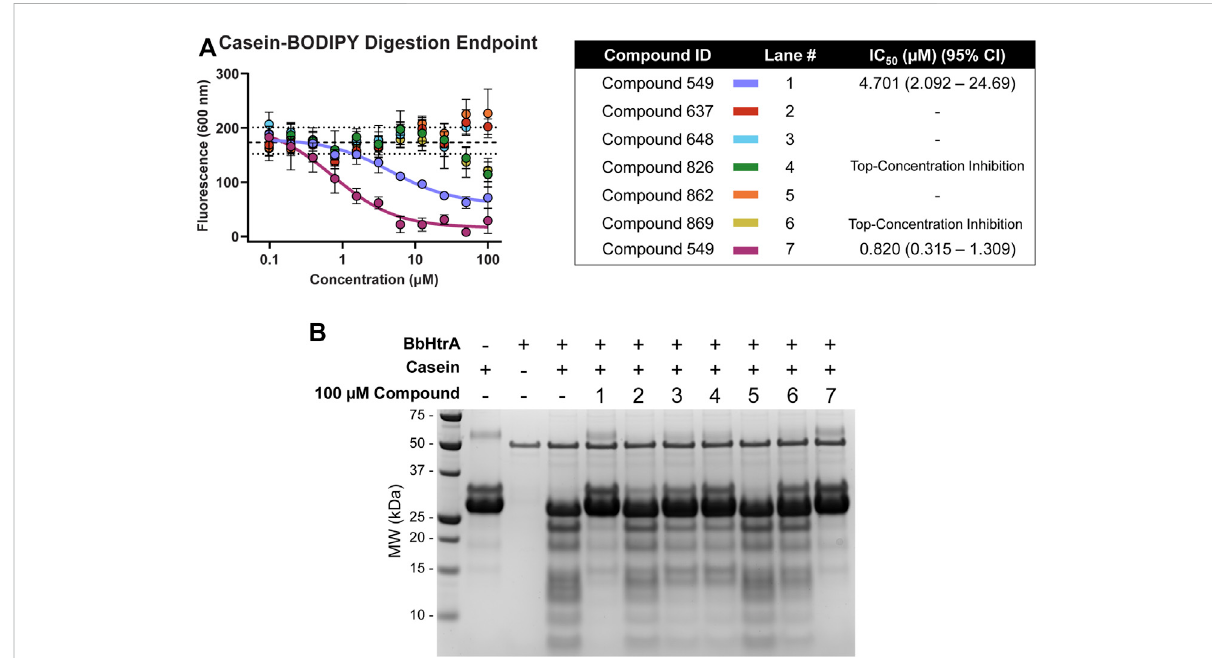
FIGURE 6 BbHtrA proteolytic activity in the presence of hit molecules. (A) Dose-response curves for hit molecules in a casein-BODIPY proteolysis assay using BbHtrA WT. Points represent the mean at each individual dose with error bars representing the standard deviation, with a dashed line and dotted lines representing the mean and ±2 standard deviations of negative control samples. The dose-response values are fi t with a four-parameter log logistic fi t to derive the IC 50 . (B) SDS-PAGE gel of casein digests with BbHtrA WT in the presence of 100 µM compound. Gels were stained with Imperial Blue protein stain